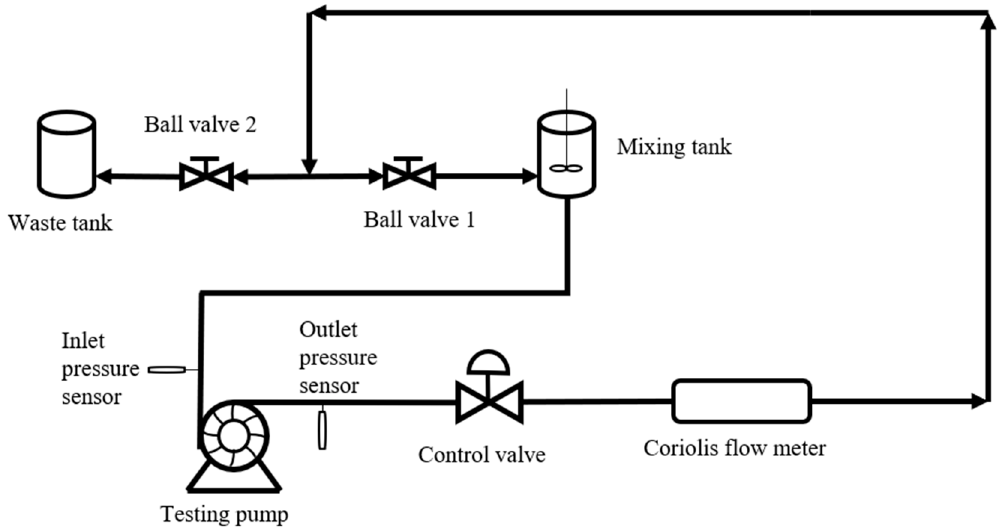
Figure 1. Experimental pipe loop setup.